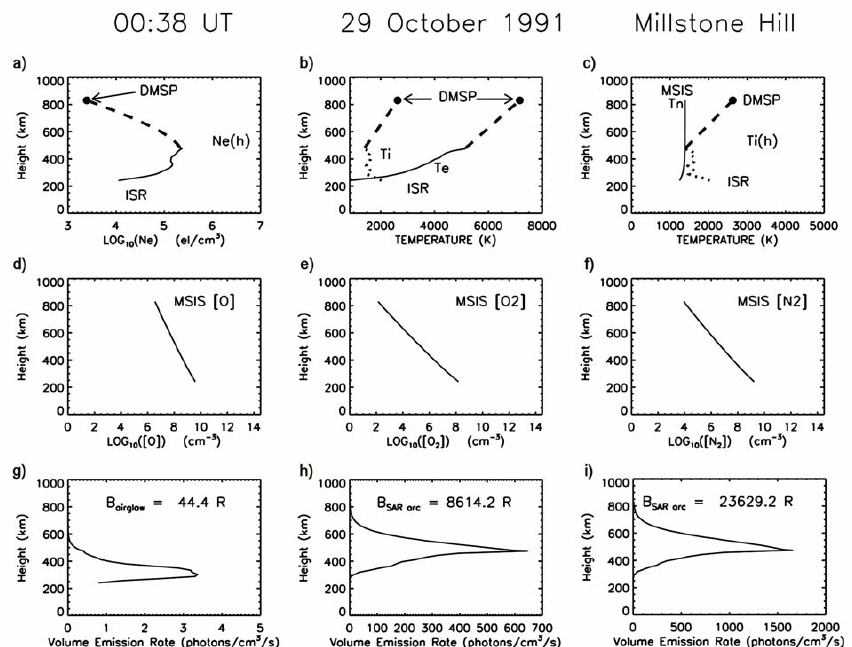
Fig. 12. Summary of input parameters and modeling results for 6300 ˚A emission on 29 October 1991 for the spatial/temporal conditions shown in Fig. 11. (a) N e (h) from the ISR and DMSP, (b) T e (h) and T i (h) from the ISR and DMSP, (c) Neutral temperature T n (h) from MSIS giving an exospheric temperature of ∼ 1300K, shown in comparison to T i (h) , (d) O (h) from MSIS, (e) O 2 (h) from MSIS, and (f) N(h) from MSIS. Using the above parameters, simulated volume emission rates for airglow appear in (g) , simulated volume emission rates for the SAR arc are shown in (h) , and simulated SAR arc emission using MSIS parameters for an exospheric temperature of 1600K (to assess uncertainties) appear in panel (i).